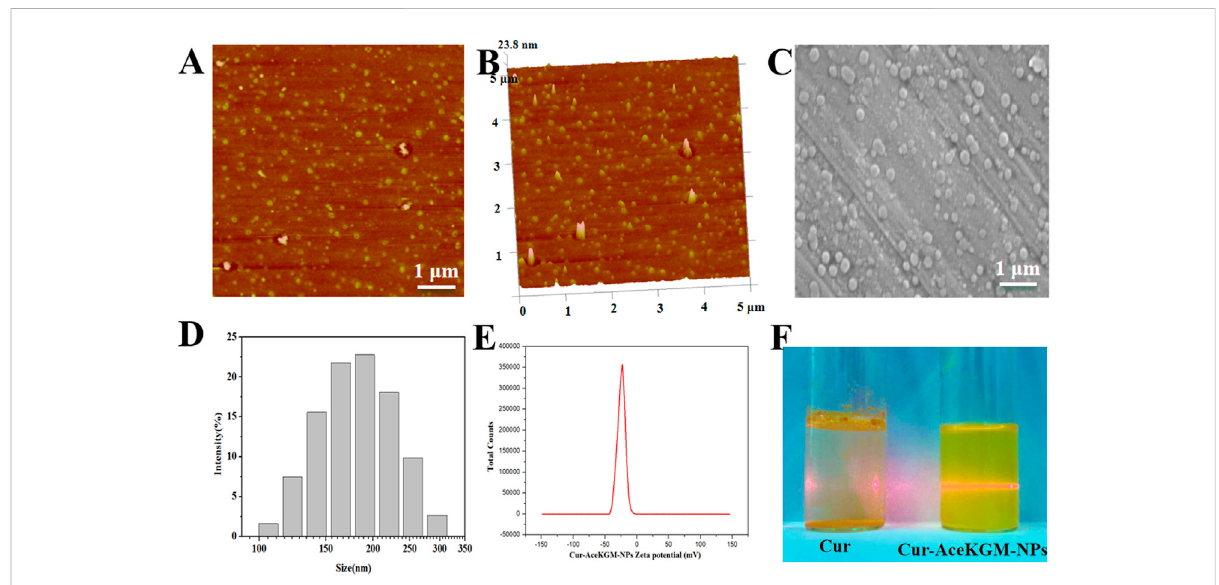
FIGURE 1 AtomicforcemicroscopyimagesofCur – AceKGMNPs. (A) 2Dimageand (B) 3Dimage.ScanningelectronmicroscopyimageofCur – AceKGM- NPs (C) . Particle size distribution (D) and zeta potential (E) of Cur – AceKGM NPs. The dispersibility of Cur and Cur – AceKGM NPs in PBS (F) .